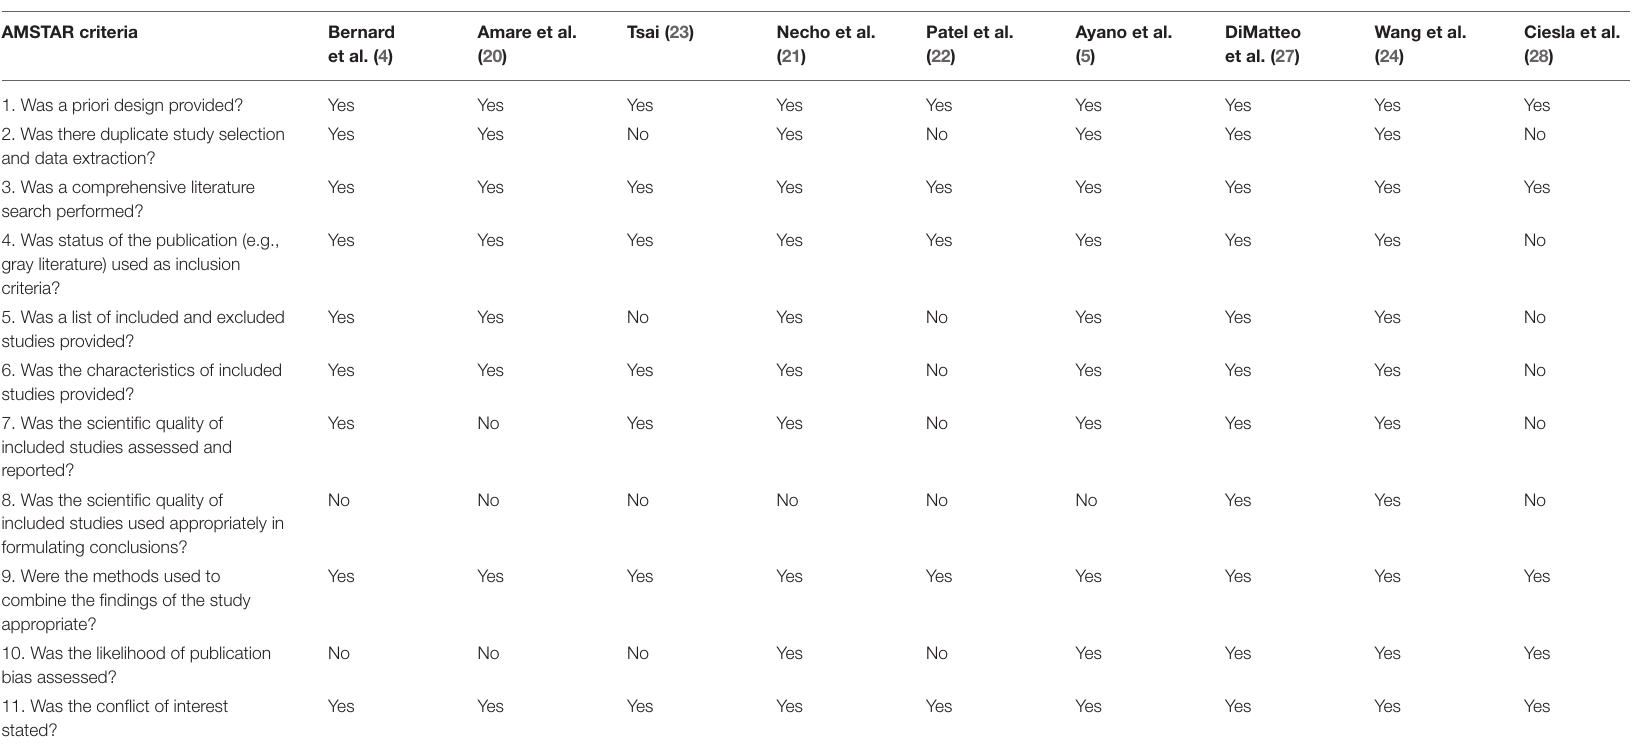
TABLE 2 | AMSTAR score of included reviews on depressive symptoms/major depression and associated factors on HIV/AIDS